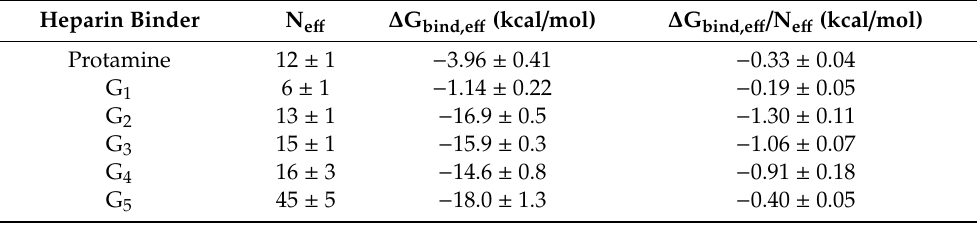
Table A2. E ff ective free energy of binding ( ∆ G bind,e ff ), number of e ff ective protamine / dendrimer positive charges (N e ff ), and e ff ective-charge-normalized free energy of binding ( ∆ G bind,e ff / N e ff ) for protamine and the di ff erent generation EDA-core PAMAM dendrimers (G 1 -G 6 ) in complex with heparin as derived from atomistic MD simulations. Adapted from [33] with the permission of The Royal Society of